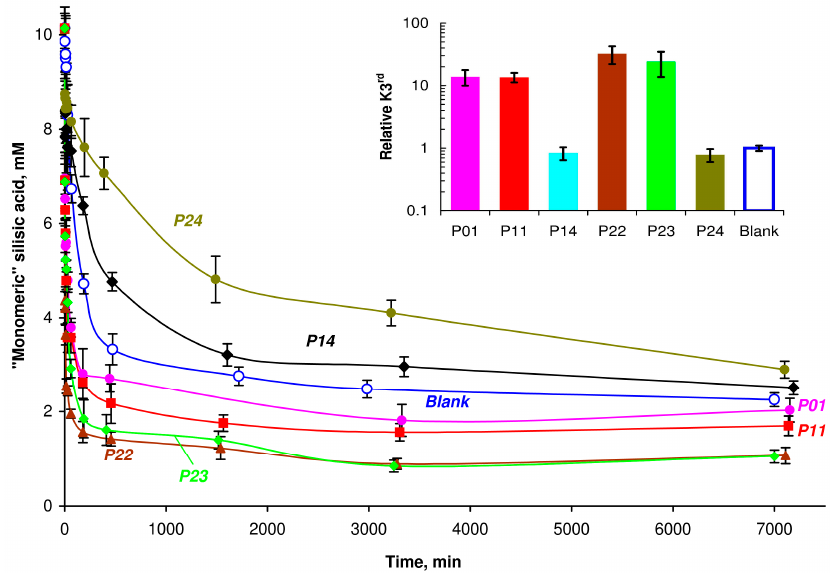
Figure 7. Effect of the new copolymers on condensation of silicic acid at pH 7. The k third constants for the rate of Si(OH) 4 condensation at initial stage (0–60 min) are relative to the blank. Initial Si(OH) 4 concentration is 10 mM, polymers = 1.5 g · L − 1 .